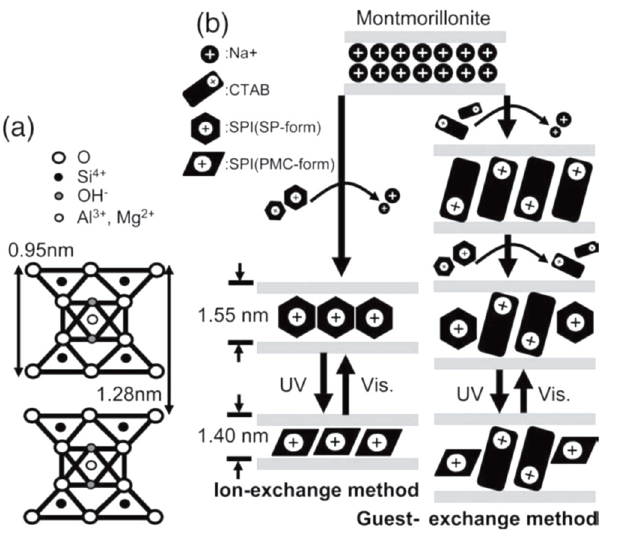
Figure 3. ( a ) The montmorillonite clay structure; ( b ) Mechanism for the intercalation of SPI by the ion- and guest-exchange methods for clay, and the conformational change of SPI in clay interlayers by photoisomerization. This image was published in Thin